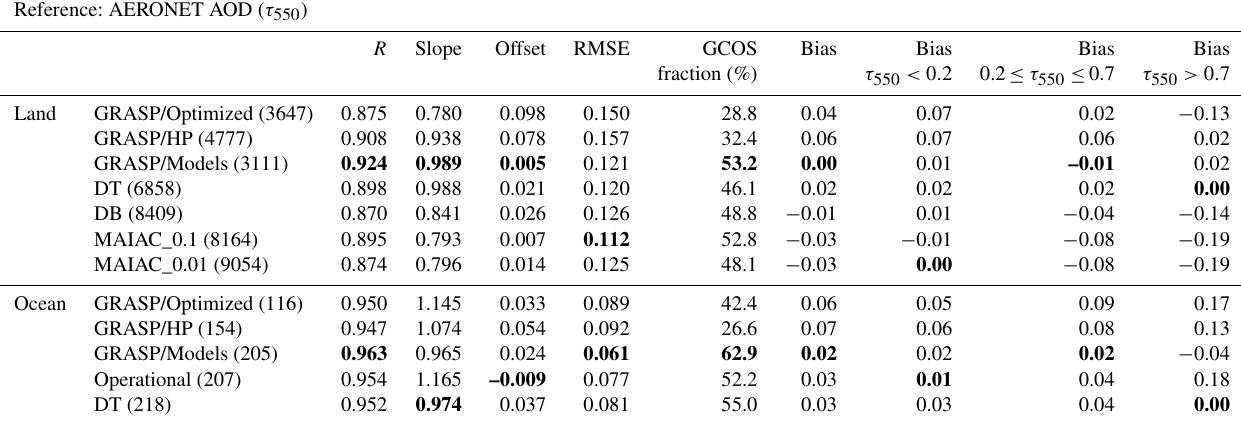
Table 9. Statistics of PARASOL and MODIS AOD products against collocated AERONET AOD at 550nm over land and ocean. Reference: AERONET AOD ( τ 550